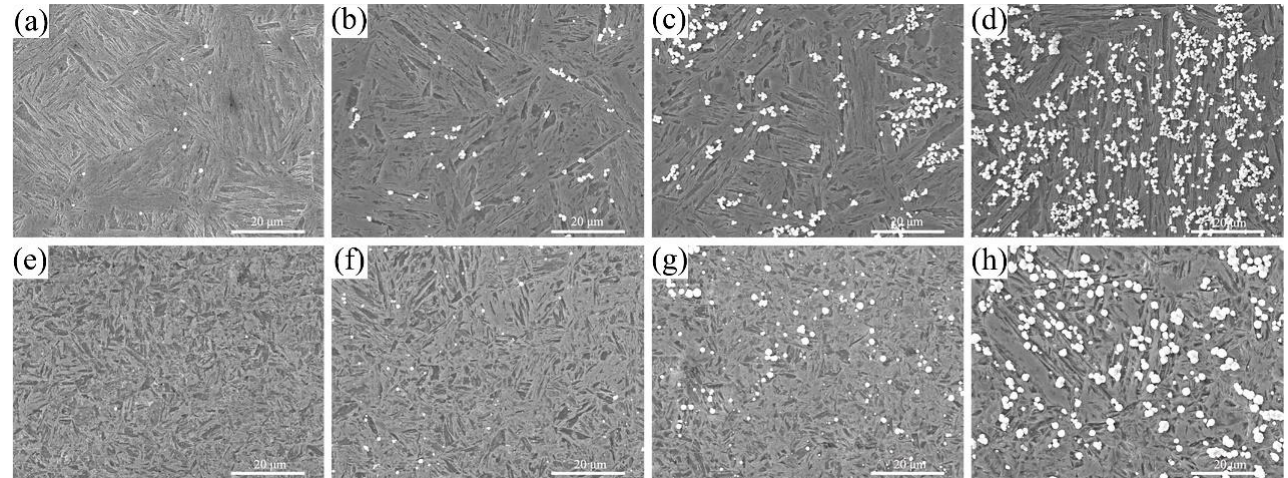
Figure 5. SEM micrographs of HMT test specimens charged for 20, 60, 90, and 120 min: ( a – d ) A-1200 and ( e – h ) A-1800.